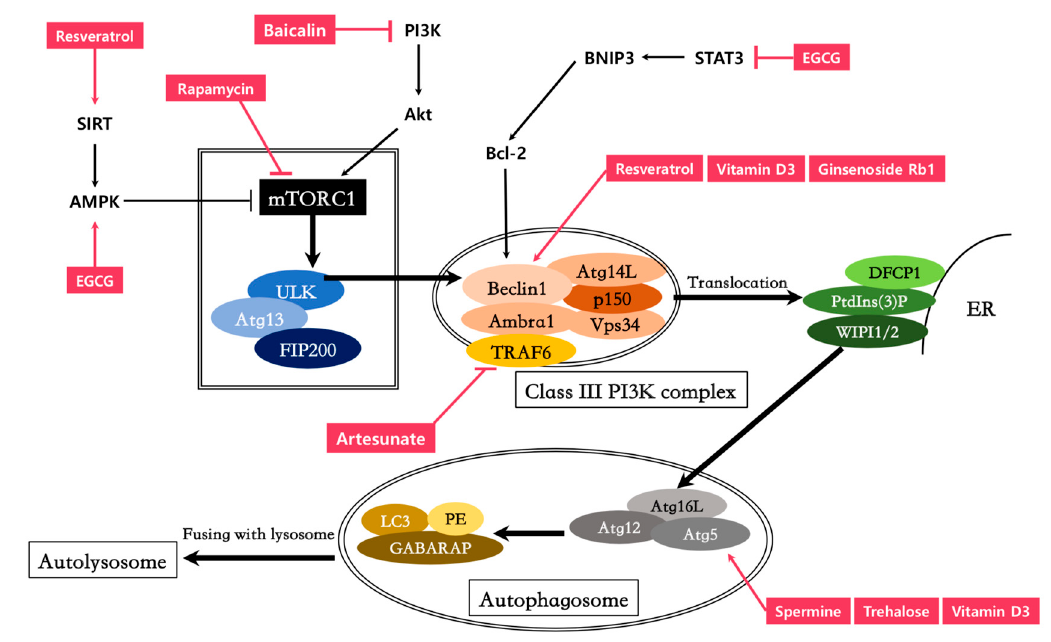
Figure 1. Compounds targeting the autophagy pathway for immuno-modulation. Akt, Protein Kinase B; SIRT, Sirtuins; TRAF, TNF Receptor Associated Factors; Atg, Autophagy related gene; FIP200, Family interacting protein of 200 kD; Ambra1, Activating molecule in Beclin 1-regulated autophagy; STAT3, signal transducer and activator of transcription 3; Bcl-2, B-cell lymphoma 2 .